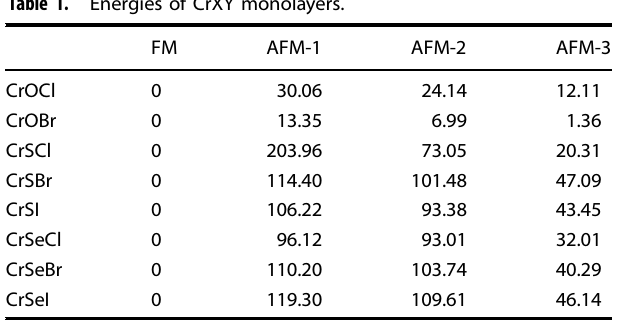
Calculated relative energies (meV/Cr) for various magnetic con fi gurations of CrXY monolayers, as shown in Fig. 1b. The FM state is chosen as energy